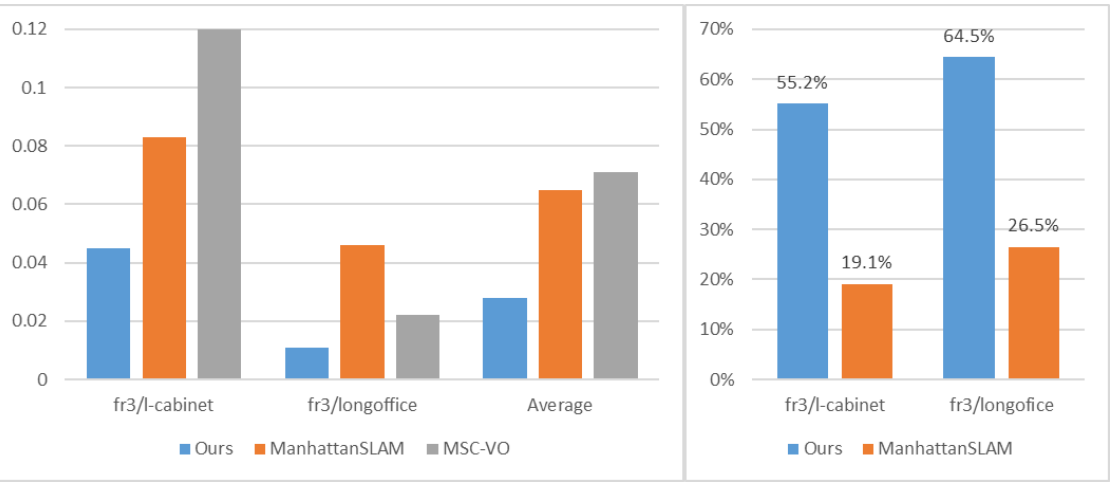
Figure 11. Left : Comparison of ATE RMSE (M) for sequence fr3/l-cabinet, fr3/longoffice. Right : The percentage of MFs detected from each sequence.